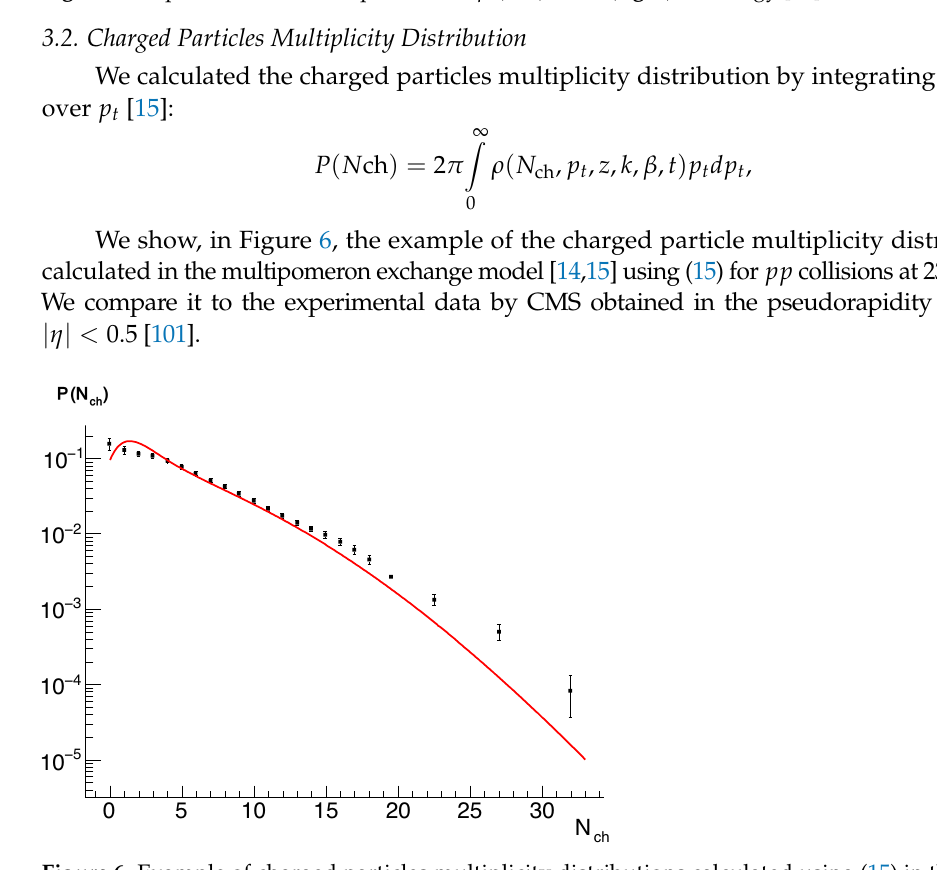
Figure 6. Example of charged particles multiplicity distributions calculated using (15) in the multi- pomeron exchange model [14,15] for pp collisions at 2.36 TeV. Experimental data are from